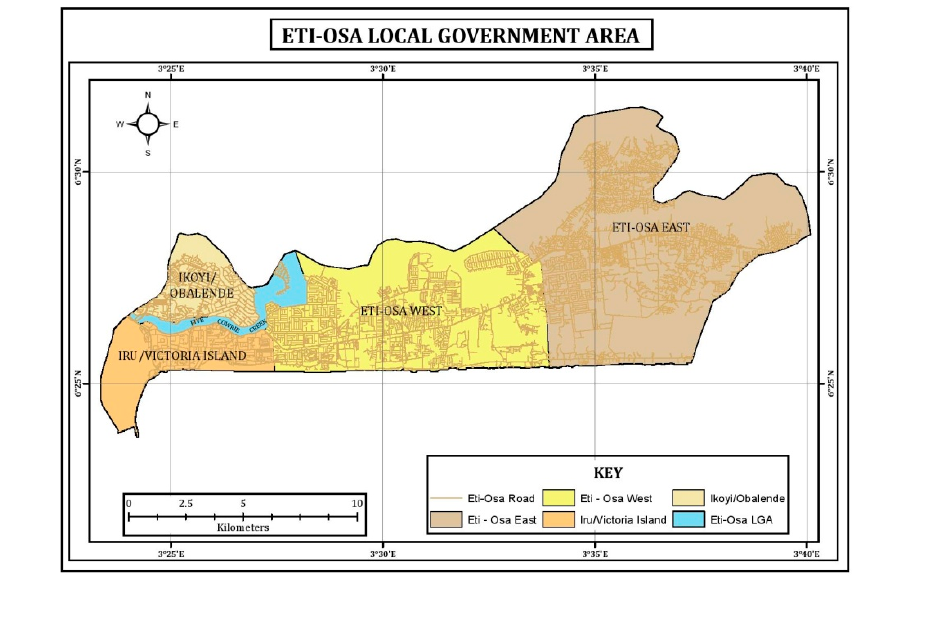
Figure 1. Map of Study